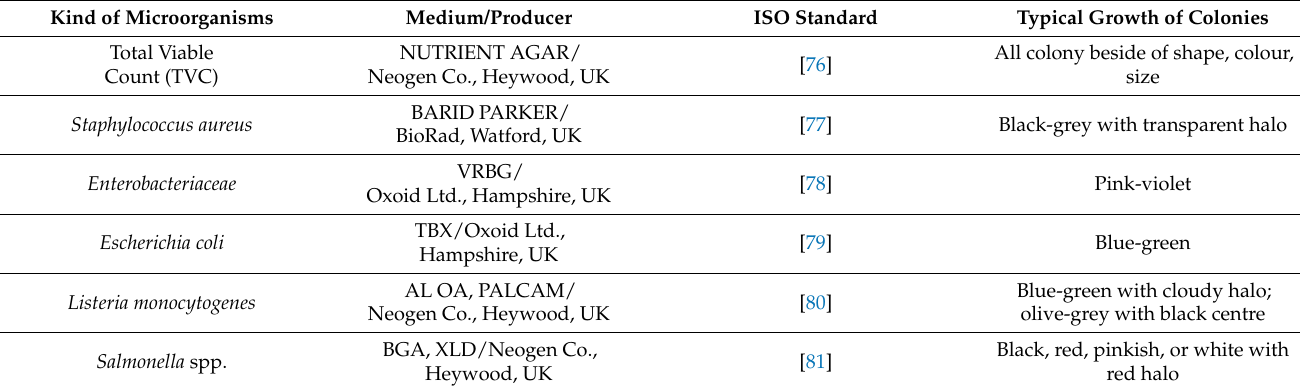
Table 1. Kind and characteristics of reference